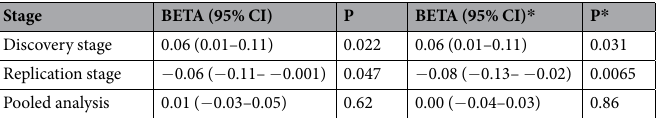
Table 4. Replication and pooled analysis of the association of VEGFA rs943080 with visual acuity changes during 12 months of ranibizumab treatment. * Adjusted for age and sex, CI: confidence